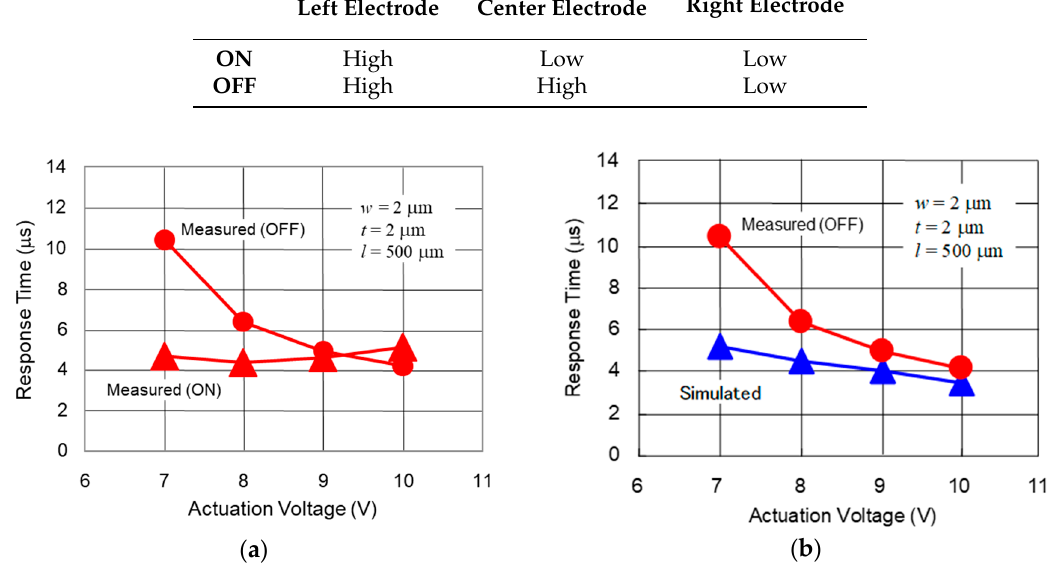
Figure 7. ( a ) Measured response time as a function of actuation voltage; ( b ) comparison with simulation in the off-state.